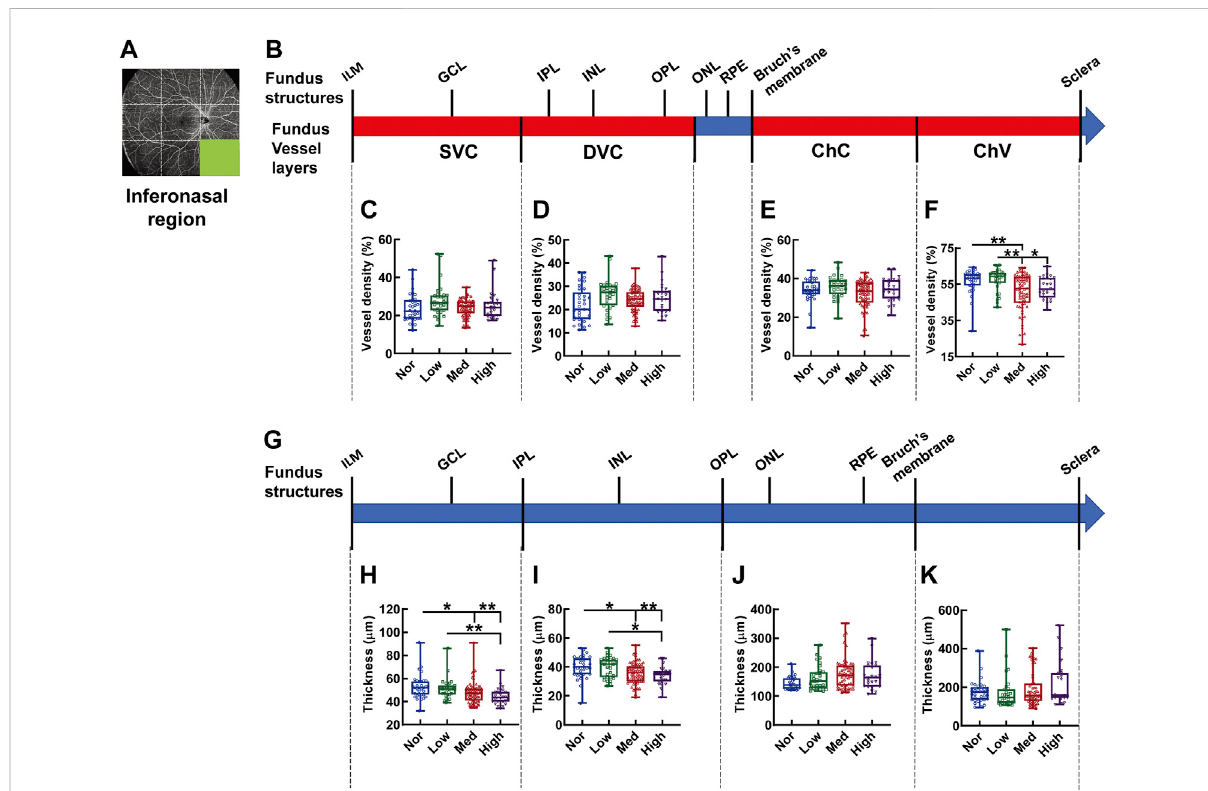
FIGURE 11 Vessel layer densities and structure thicknesses at the inferonasal region of the fundus. Position of the inferonasal region of the fundus is illustratedin (A) .Schematicillustrationofvessellayersinthefundusisshownin (B) .Vesseldensitiesofsuper fi cialvascularcomplex (C) ,deepvascular complex (D) , choriocapillary (E) , and choroidal vessel (F) layers are quanti fi ed and compared. Schematic illustration of segments in the fundus is shown in (G) . Thicknesses of the segments from IML to IPL (H) , from IPL to OPL (I) , from OPL to Bruch ’ s membrane (J) , and from Bruch ’ s membrane to the sclera (K) are quanti fi ed and compared. * p < 0.05, ** p < 0.01. SVC, super fi cial vascular complex; DVC, deep vascular complex; ChC, choriocapillary layer; ChV, choroidal vessel layer; NOR, normal group; Low, low-myopia group; Med, medium-myopia group; High,